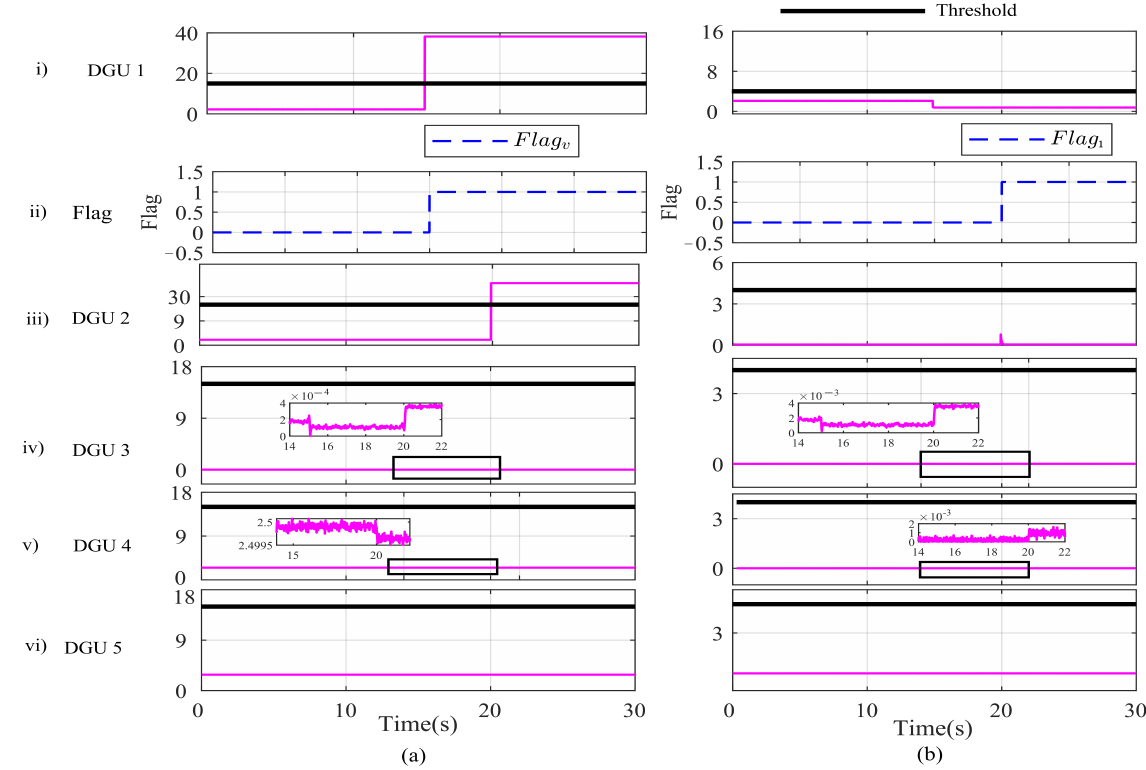
Figure 10. ( a , b ) Voltage residuals of the DGUs during voltage sensor fault in DGU 1 and DGU